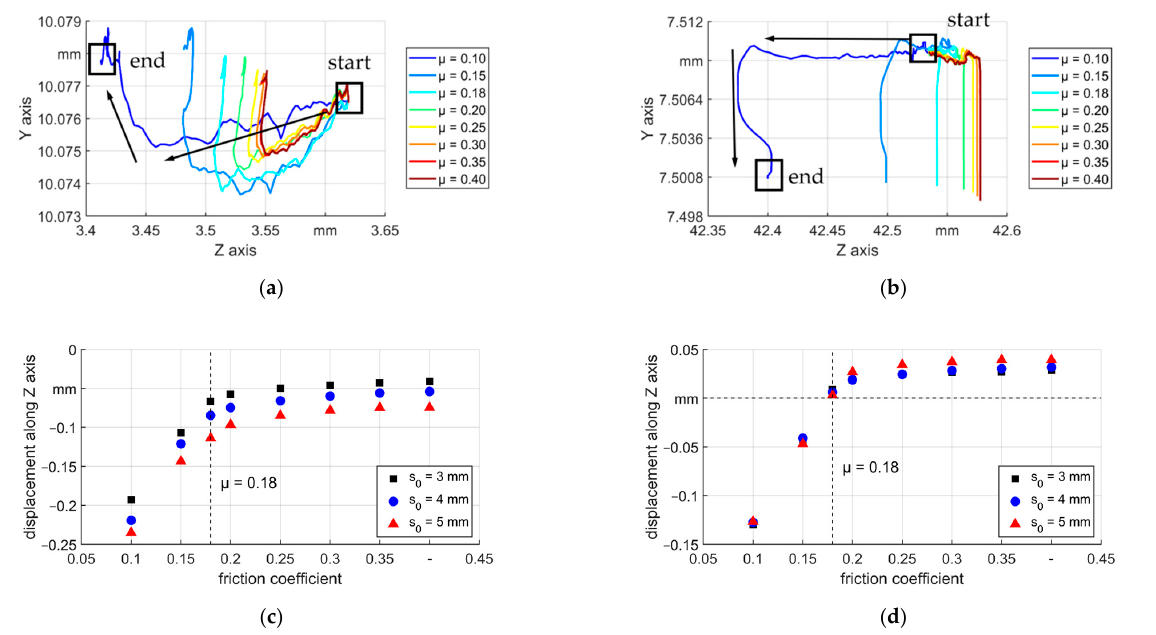
Figure 10. Routes and axial displacements of boundaries A and B, ( a ) routes of A, s 0 = 5 mm, ( b ) routes of B, s 0 = 5 mm, ( c ) axial displacement of A, and ( d ) axial displacement of B. The distance between A and B when the die was completely closed consisted of both elastic and plastic elongation of the deformed area. Since the two boundaries were se- lected beyond the deformation area, in two consecutive strokes the elastic elongation be- tween A and B could be treated as a constant. Then the difference of the distance between them shows qualitatively the plastic elongation of the deformed area of the workpiece, see Figure 11. Three regions (1, 2, and 3 in Figure 11) according to the friction coefficient could be identified. The first region was from μ = 0.1 to μ = 0.15: when μ = 0.1, the work- piece tended to be pushed back from the dies (backwards shifting), so the highest back- ward motion could be seen (compare also Figure 10c, d). Furthermore, a surface with the lowest μ means the lowest resistance to material flow along with both directions. In Figure 9, it could be seen that the wall thickness before entering the deformation area reached the highest value for μ equals 0.1. This means more material was fed into the dies in each stroke, so the values of plastic elongation of all the tubes with μ equals 0.1 were the high- est. When μ increased to 0.15, the backward shifting was reduced and the backward ma- terial flow. Additionally, the resistance for forwarding material flow was higher and the increased wall thickness was also less, so the values of elongation were lower. Second region: from μ = 0.15 to 0.18 (T5) or 0.2 (T3 and T4) depending on the wall thickness, the back shifting was reduced to zero (compare Figure 10d), so the workpiece was held tightly by the dies, which benefited the reduction of the cross–section and led to higher elonga- tion. Third region: higher than μ = 0.18 (T5) or 0.2 (T3 and T4) according to different wall thicknesses. In this region, with even higher values of μ , self–locking always existed in the reduction zone. The axial material flow was restrained more in the calibration zone, which led to less elongation.